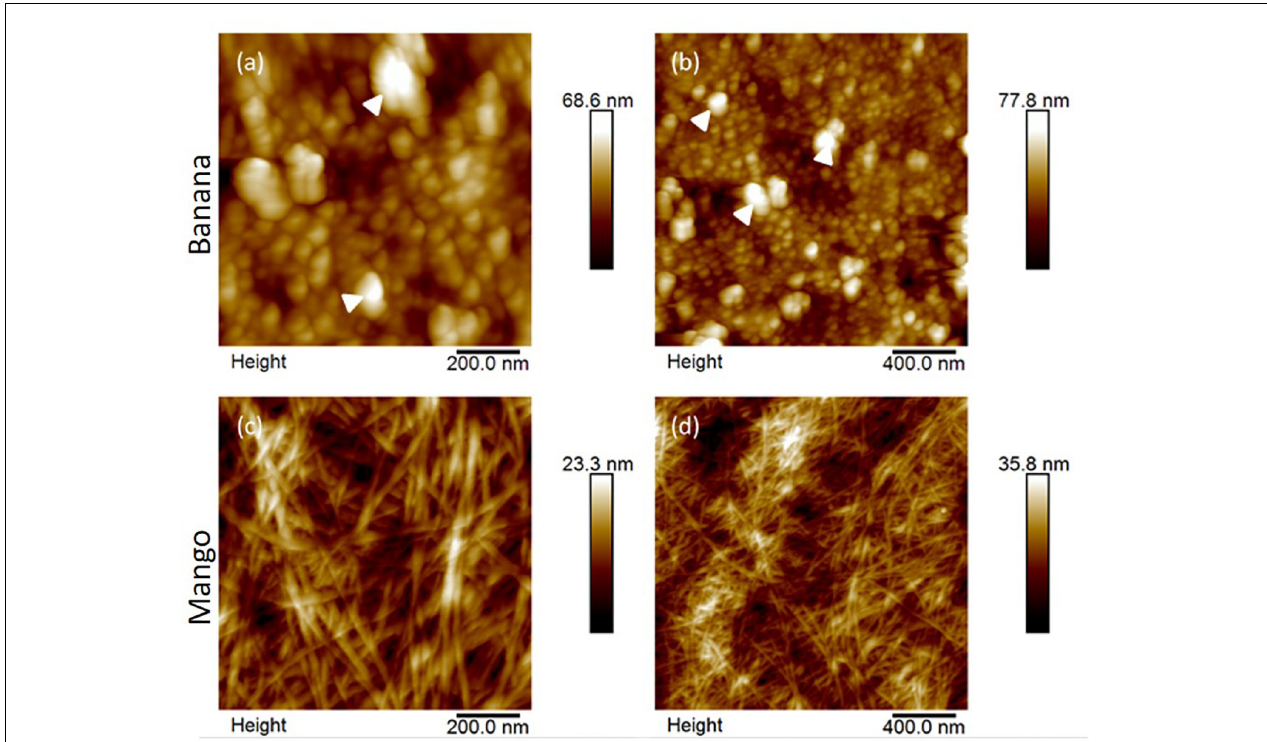
FIGURE 3 | AFM height images of banana (a,b) and mango (c,d) cells at 1 µ m (left) and 2 µ m (right) scan sizes. Large aggregates on banana cell surfaces are indicated by white arrowheads. In contrast, fibrillar structures, attributed cellulose/hemicellulose are clearly visible in the mango cell